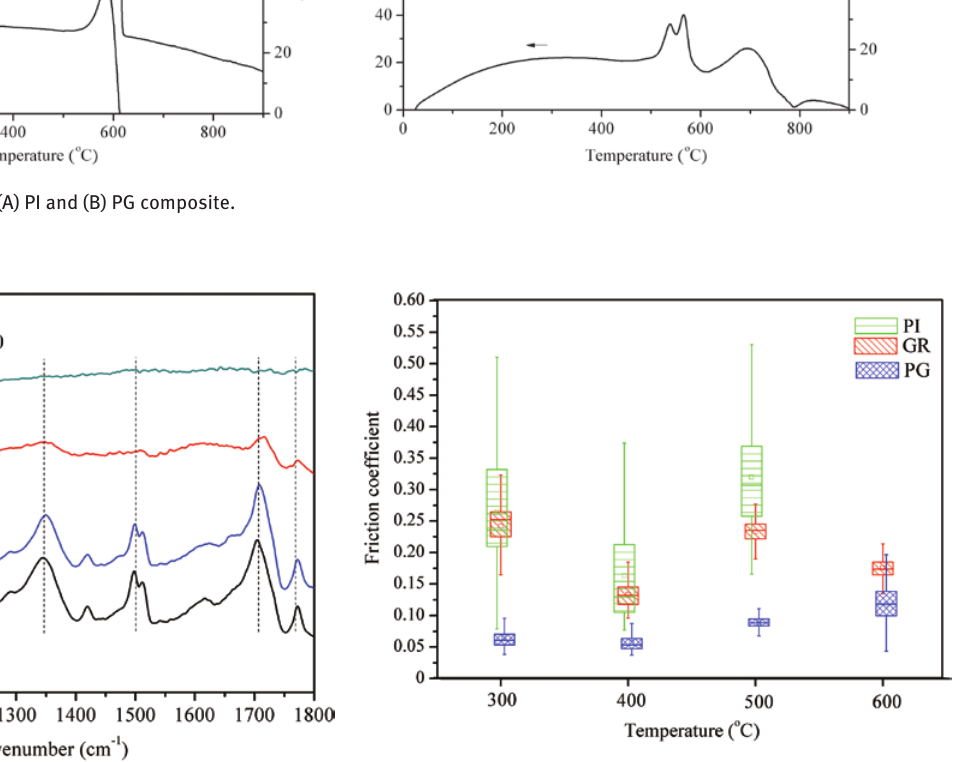
Figure 5: FTIR spectra of the as-prepared PI and PG composite as well as heat-treated PI and PG composite.